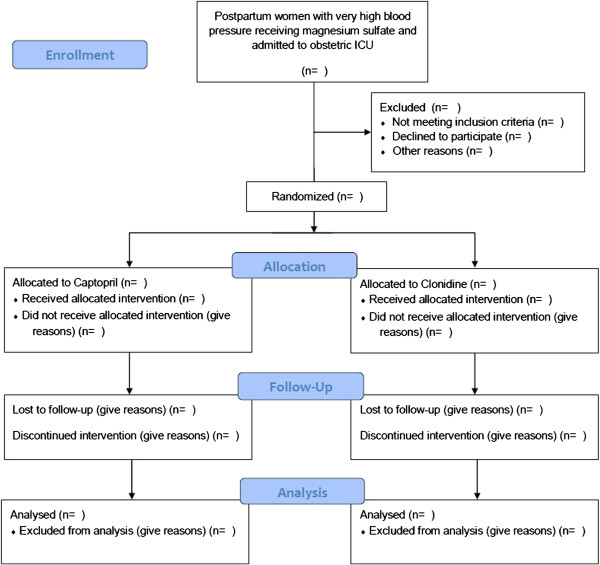
Study design and population (CONSORT, 2010)[31].